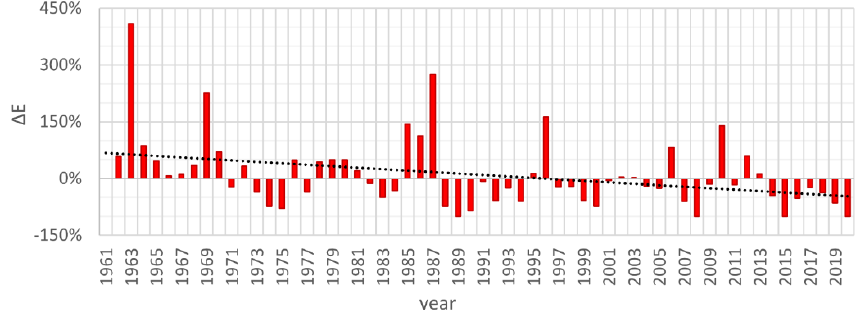
Figure 8. Relative energy for air heating compared to 1961.